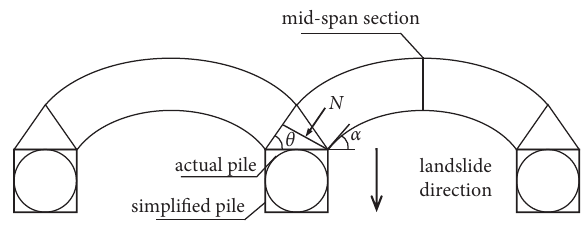
Figure 3: Force analysis of the triangular pressure zone at the arch foot.